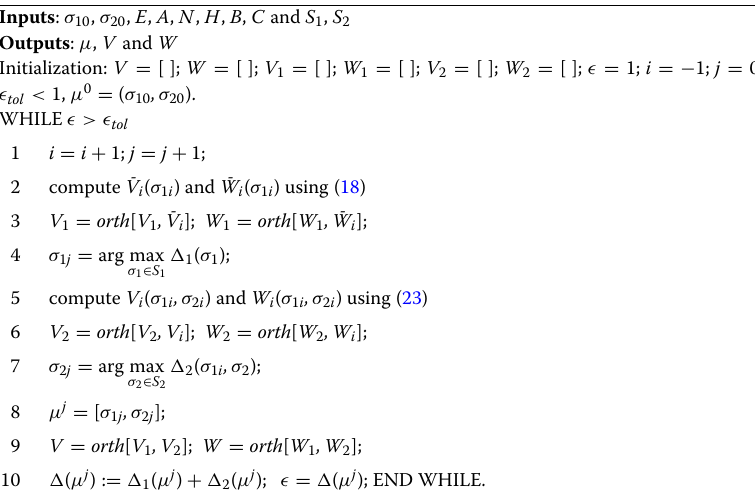
Algorithm 1 An adaptive framework for selection of interpolation